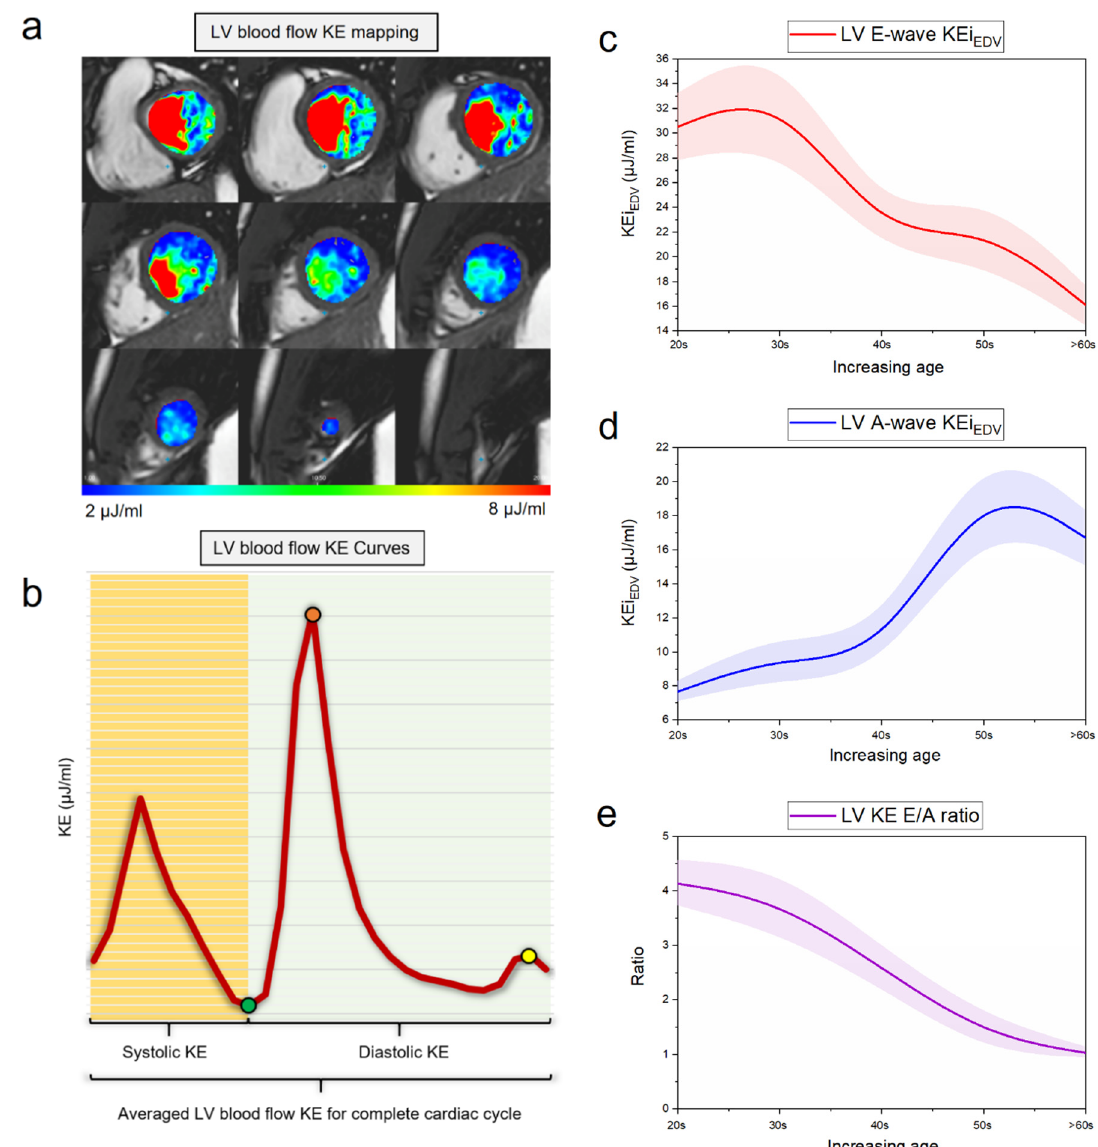
Figure 2. Left ventricular kinetic energy (KE) mapping. ( a ) Mapping of left ventricular (LV) KE using endocardial contours. This is a semi-automated method for the quantification of hemodynamically relevant parameters; ( b ) left ventricular blood flow KE curve for the whole cardiac cycle; green point: end-systolic KE; yellow point: Peak A-wave KE; red point: Peak E-wave KE; ( c ) mean line of LV E-wave KE with progressive age demonstrates that with age E-wave KE reduces; ( d ) mean line of LV A-wave KE with progressive age demonstrates that with age E-wave KE increases; ( e ) mean line of LV KE ratio with progressive age demonstrates that with age KE E/A ratio reduces.